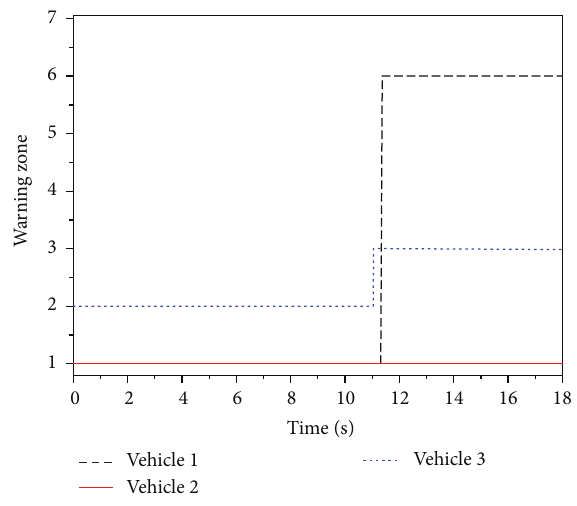
Figure 13: Warning zone change during